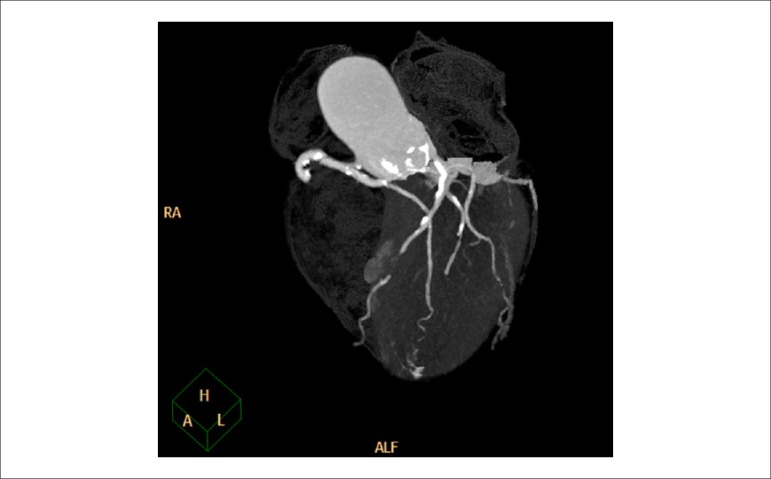
Case 10 - Coronary angio-CT showing significant coronary atherosclerosis, with multivascular calcification. Reproduced with the permission of Vitola JV.234